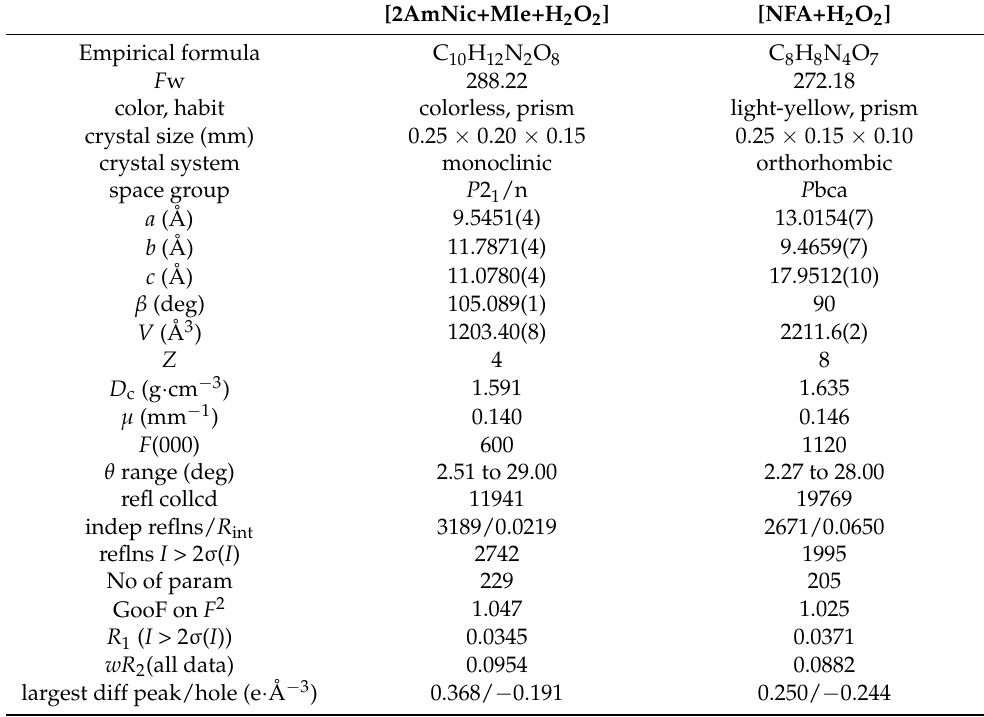
Table 2. Crystal data and refinement details of the [2AmNic+Mle+H 2 O 2 ] and [NFA+H 2 O 2 ]